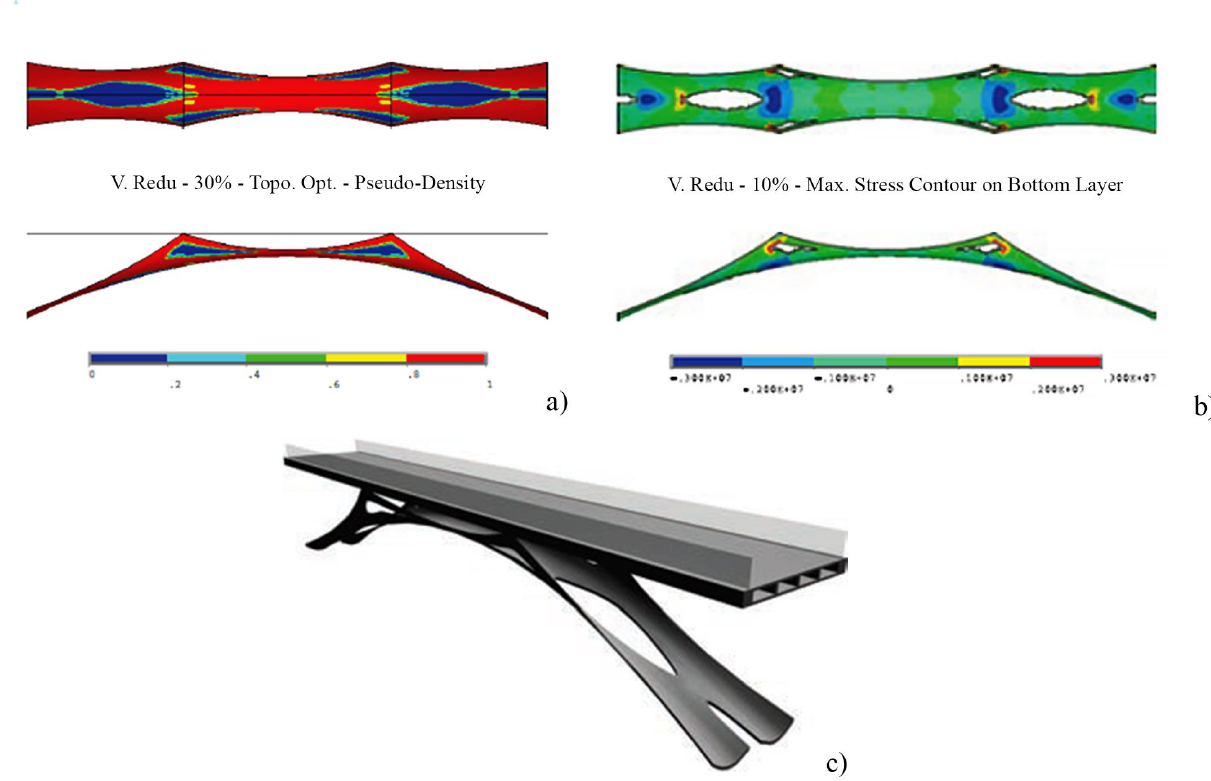
Figure 8: Topology optimization of the shell-supporting footbridge through the SIMP Method: (a) distribution of the pseudo-densities; (b) hole insertion; (c) rendering of the shell-supported footbridge after hole